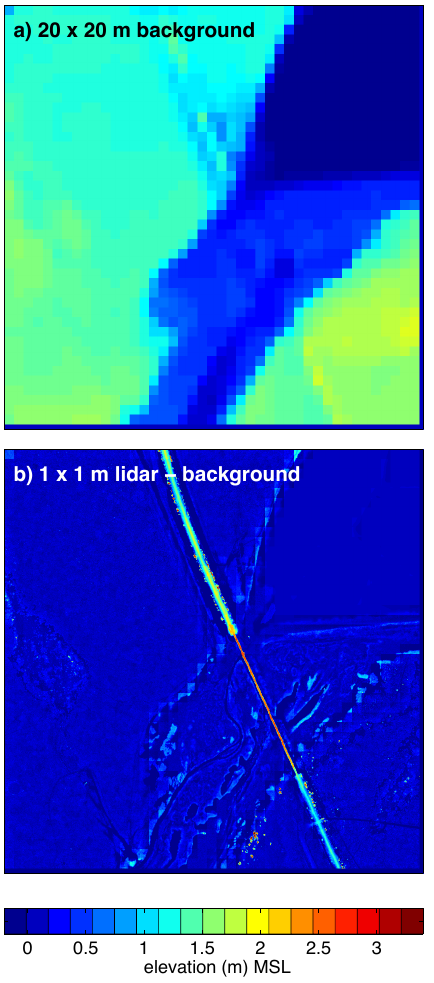
Figure 2. (a) The 20m × 20m coarse-grid background topography based on the 40m × 40m filter of Fig. 1d; (b) the difference be- tween the 1m × 1m lidar data of Fig. 1b and the coarse-grid back- ground topography.